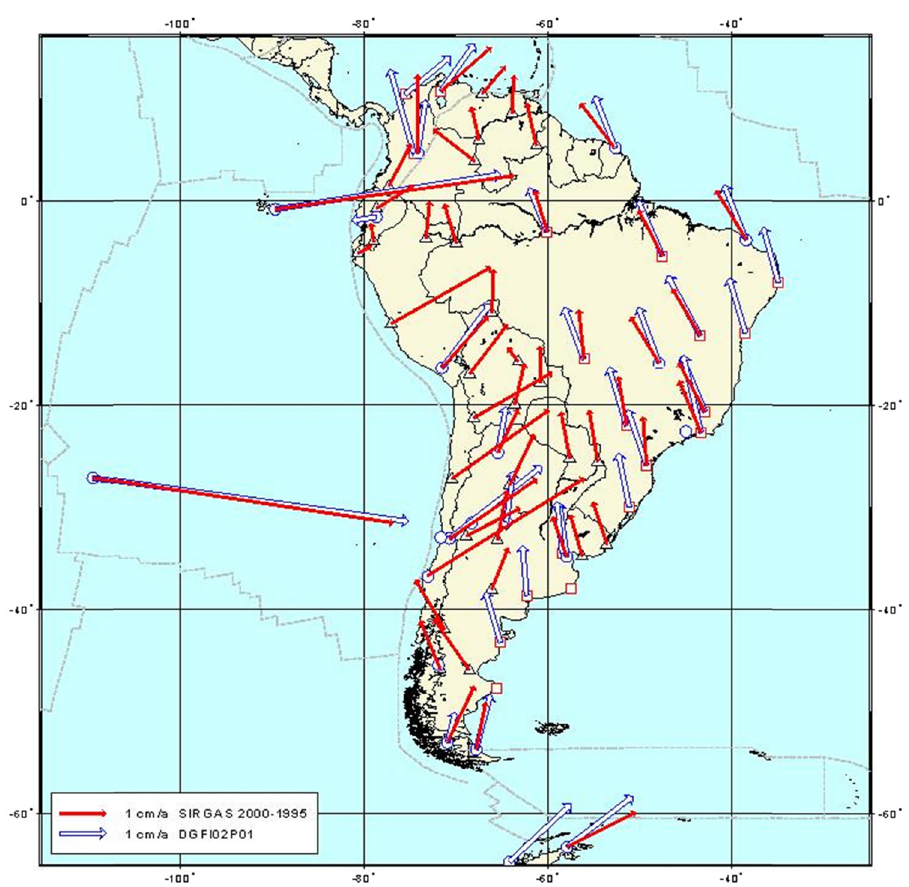
Figure 6: Comparison of SIRGAS2000 – SIRGAS1995 di ff erences and the DGFI multi - year solution.